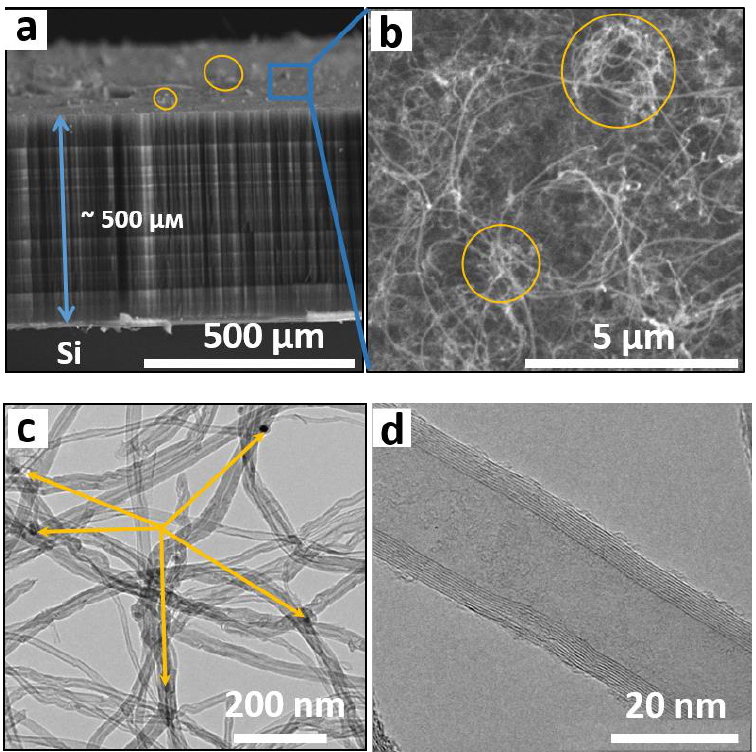
Figure 2. SEM images of side view ( a ) and top view ( b ) of CNT array. TEM images of CNTs taken with low magnification ( c ) and high magnification ( d ). Arrows in ( c ) show encapsulated iron nanoparticles.